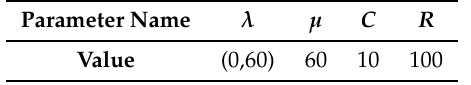
Table 2. The value of the common simulation parameters.